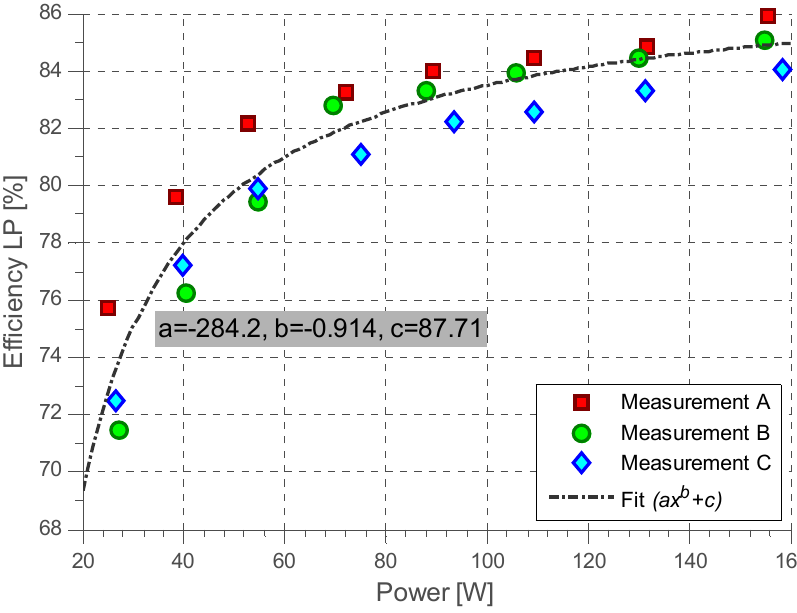
Figure 13. Efficiency of the LP side of the driveline versus the input power, i.e. , battery output power.